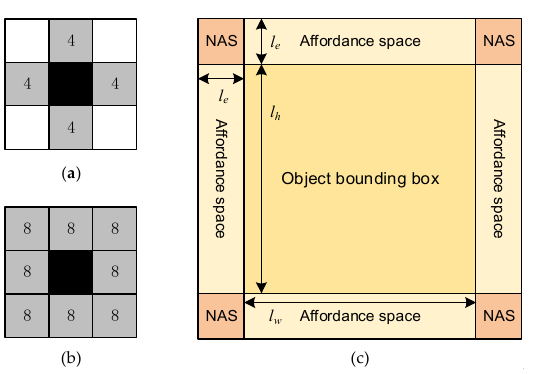
Figure 12. Object goal space: ( a ) 4-connected pixels, ( b ) 8-connected pixels, ( c ) theoretical model of the object goal space. NAS is short for nona ff ordance space. The square’s edge length of NAS is l e . The width and height of the a ff ordable space are l w and l h .